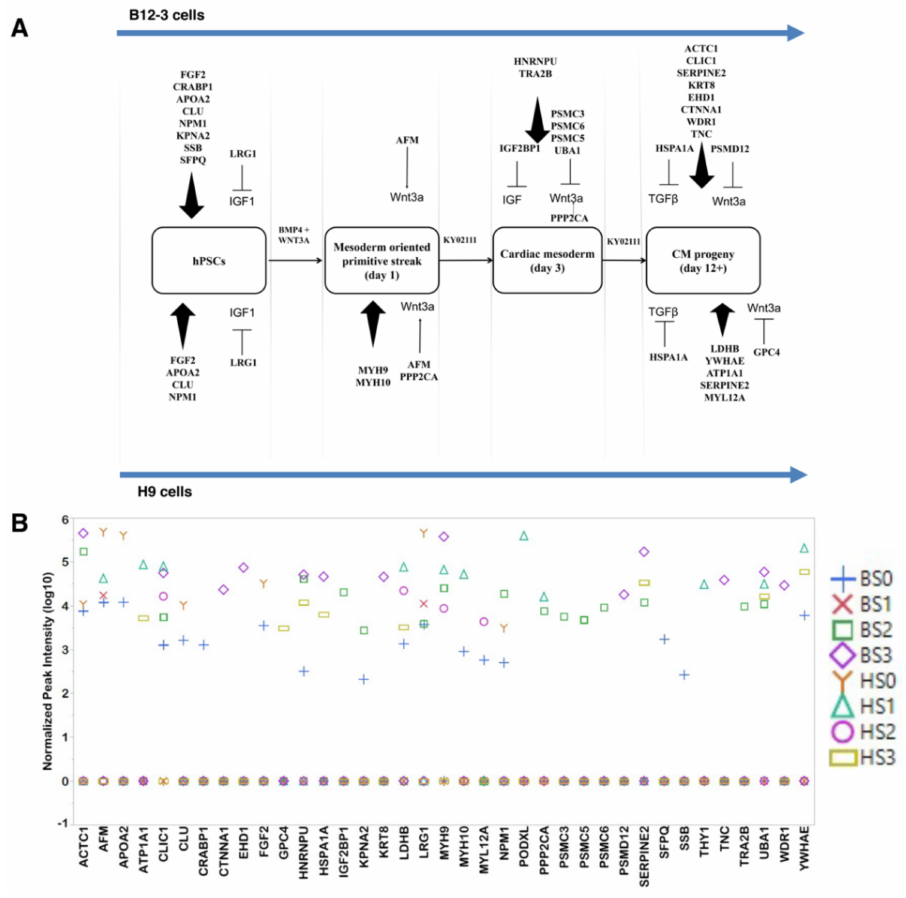
Figure 6. Detected exosomal proteins with potential roles in hPSC specification toward CMs. ( A ) Proteins that influence differentiation, and ( B ) their relative abundance depicted by a scatter